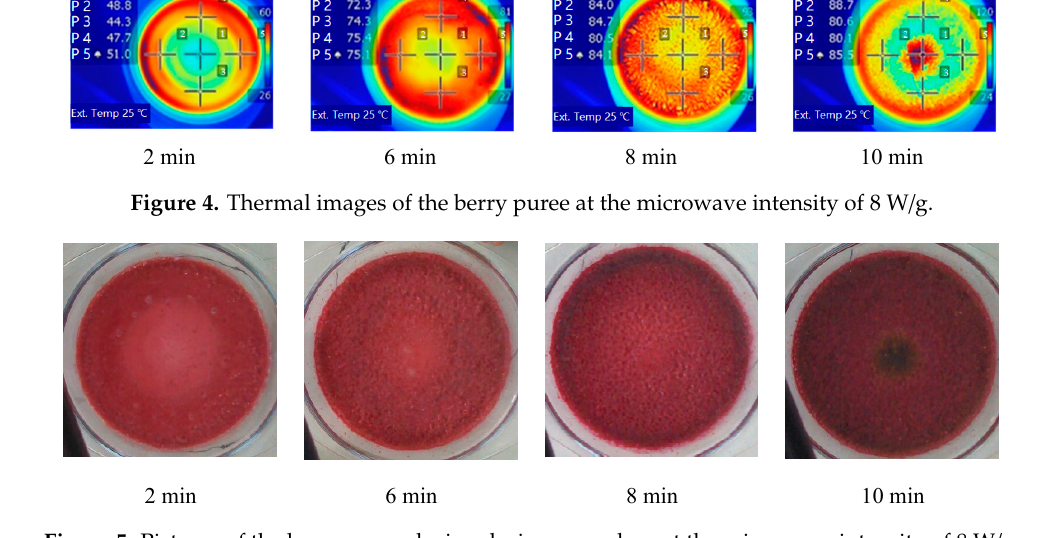
Figure 5. Pictures of the berry puree during drying procedure at the microwave intensity of 8 W/g.